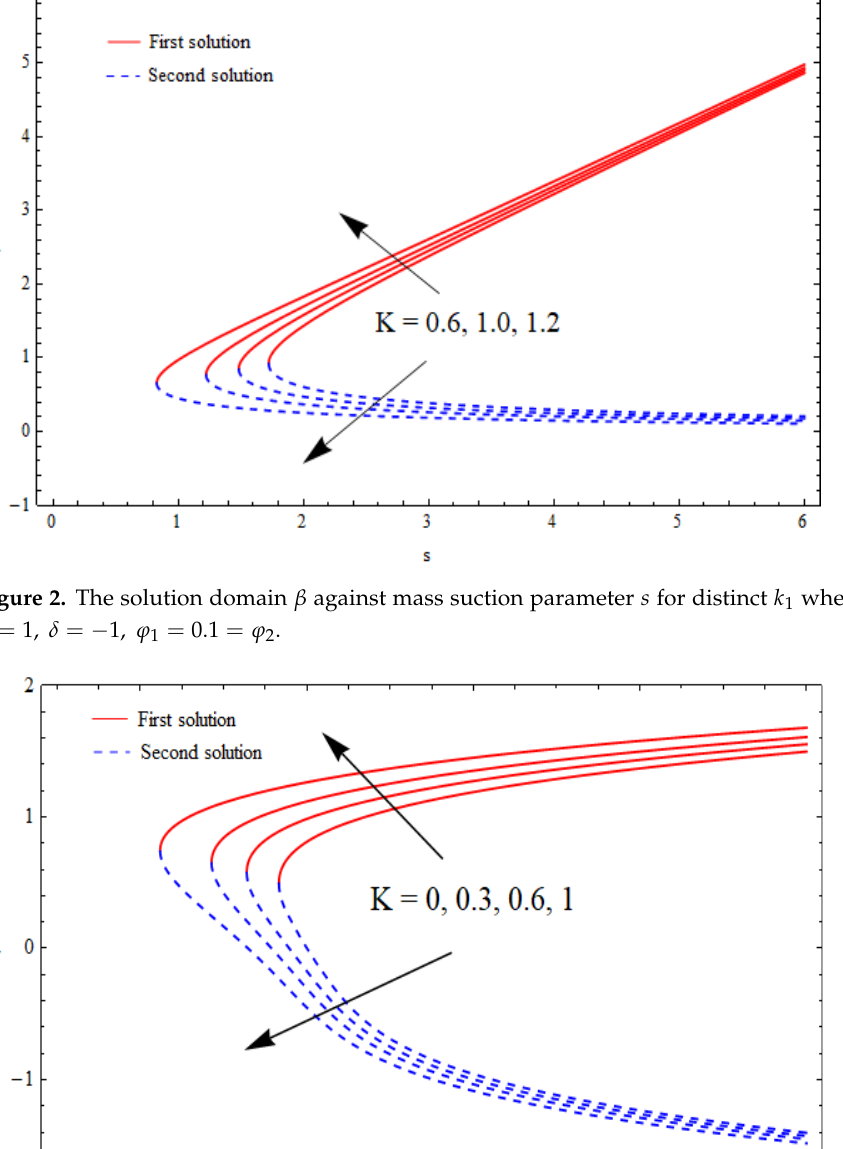
 for distinct 1 k